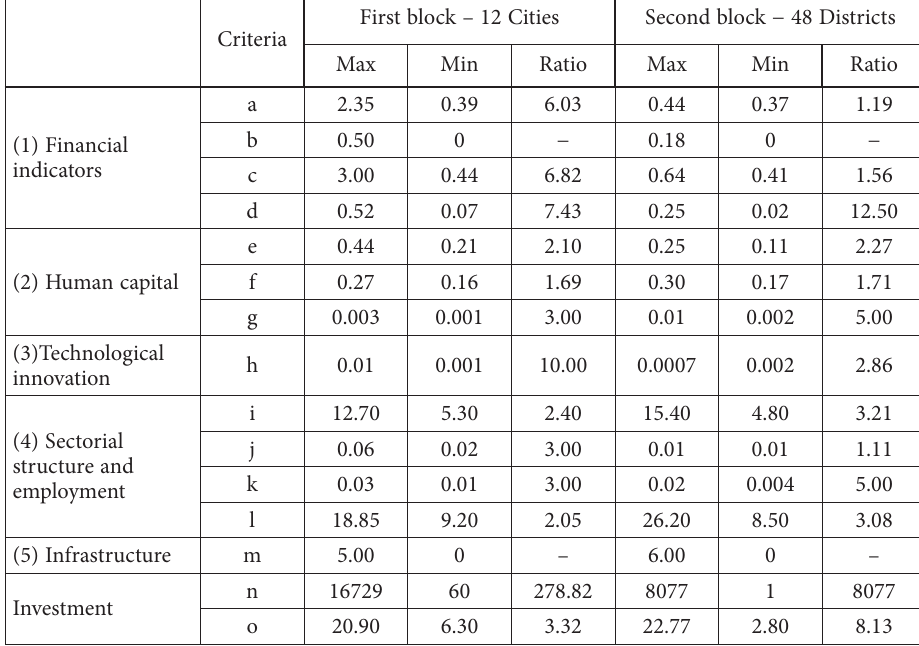
Table 2. Ratios of maximum and minimum of criteria (made by authors according to Statistics Lithuania, 2017) First block – 12 Cities Second block − 48 Districts Criteria